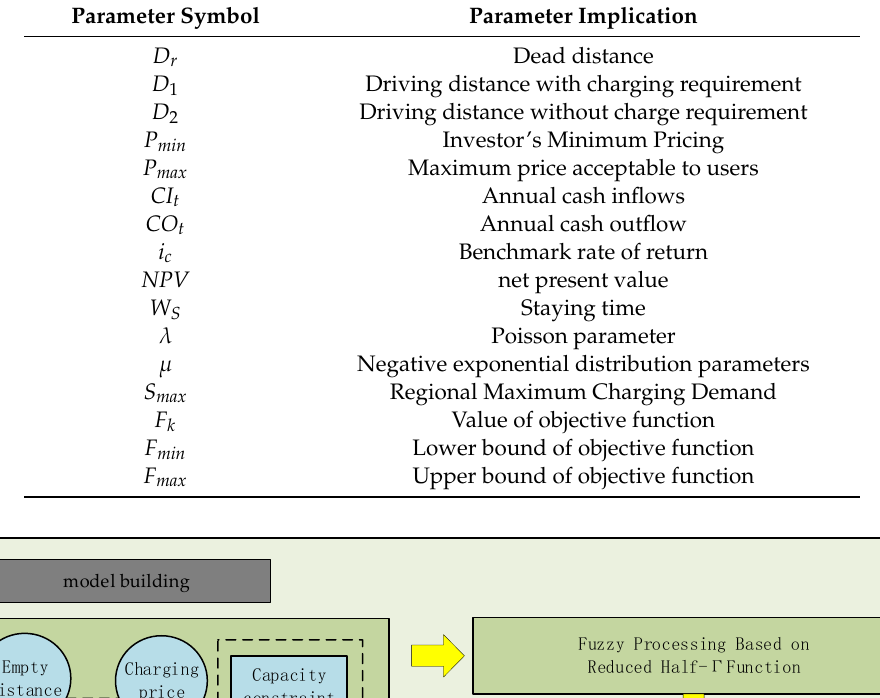
Table 1. Symbols and Implications of Parameters.